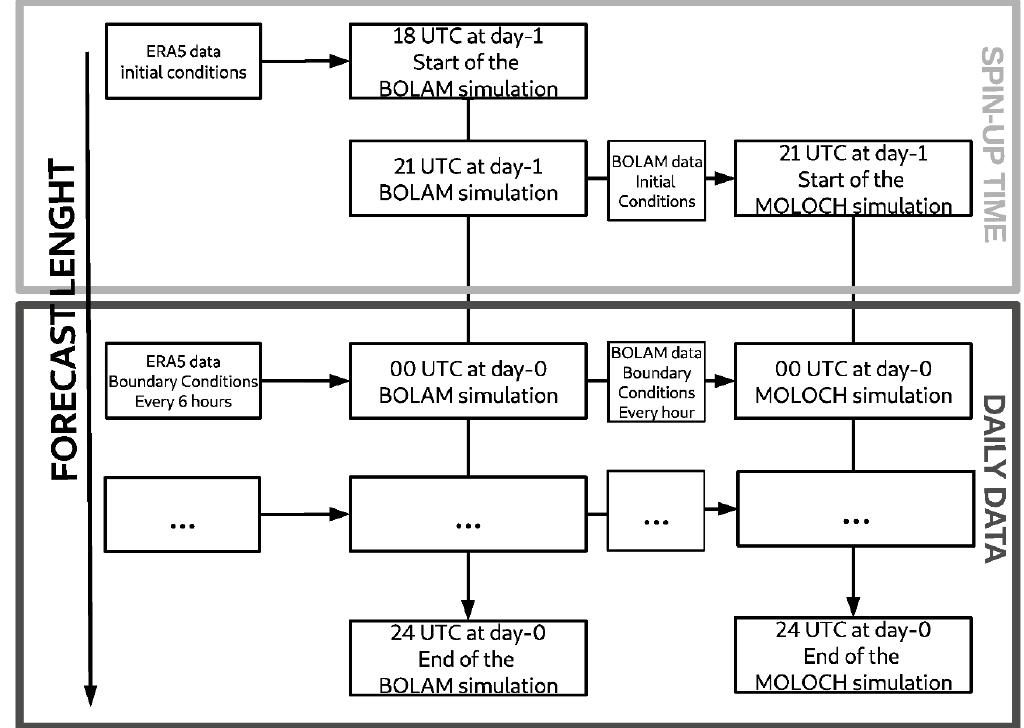
Figure 2. Modelling setup for the production of one single day of